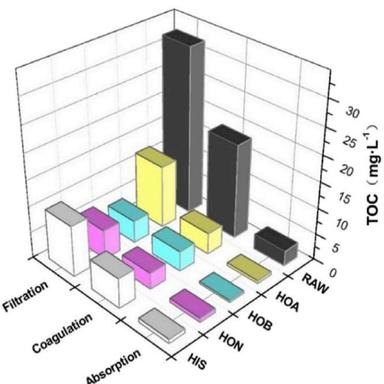
Characterization of hydrophilicity/hydrophobicity during the stepwise process (RAW-the raw bio-treated coking wastewater, HOA-hydrophobic acid, HOB-hydrophobic base, HON-hydrophobic neutral, HIS-hydrophilic substances).